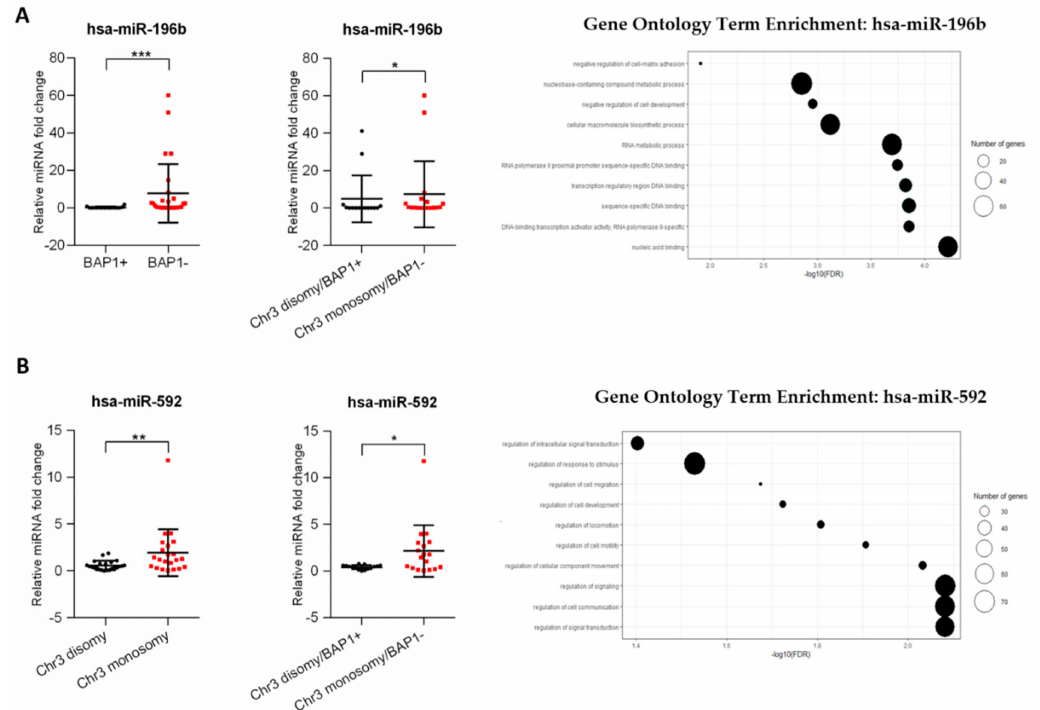
Figure 4. The correlation between selected miRNAs with BAP1 expression and chromosome 3 monosomy in uveal melanoma primary tumors. The results are displayed as relative miRNA fold change calculated as log 2 - ∆∆ Ct. The statistical di ff erences between two groups were analyzed with the Mann–Whitney test where: * p < 0.05, ** p < 0.01, *** p < 0.001, **** p < 0.0001 (left). Gene ontology (GO) enrichment analysis for hsa-miR-196b and has-miR-592. Results are displayed as − log 10 (FDR) of given GO terms. The size of dots corresponds to the number of miRNA target genes detected in the given GO term (right). The analyses were performed for hsa-miR-196b ( A ) and hsa-miR-592 ( B